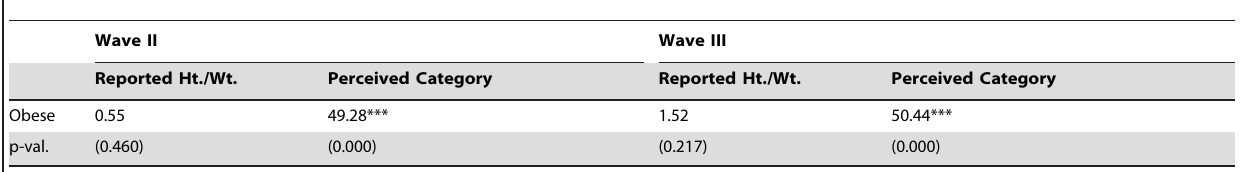
Table 4. Chow Test of the Effect of Actual Vs. Reported Obesity.